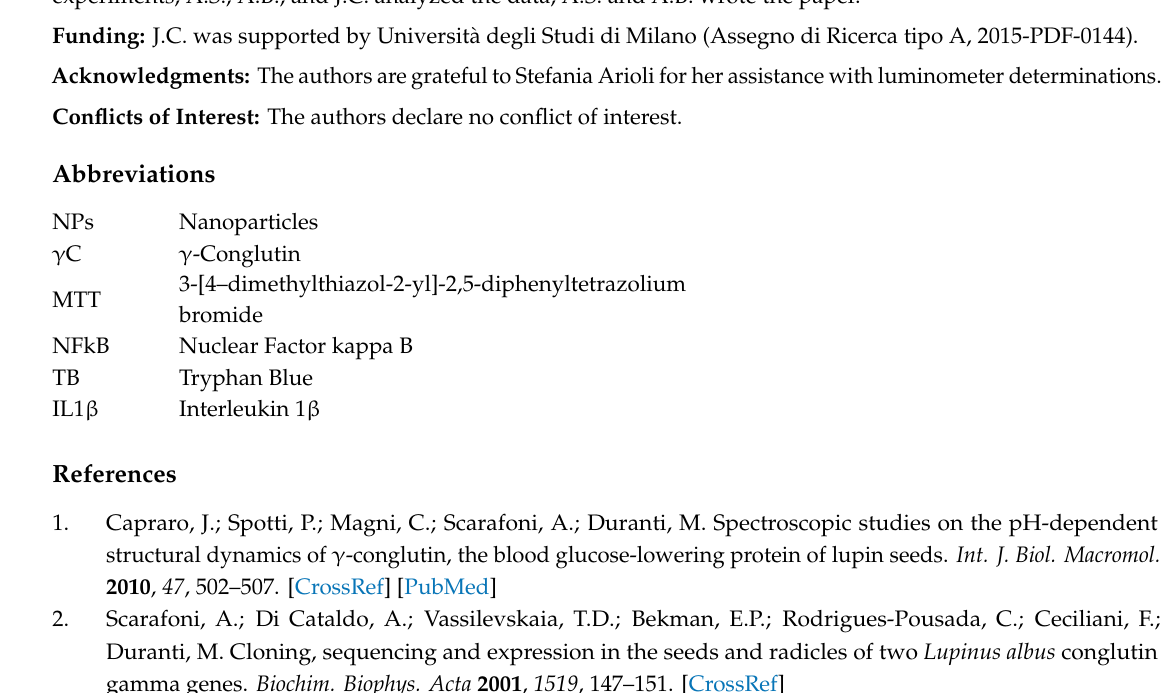
Figure S1: Prediction of peptides toxicity calculated by using the ToxinPred method [31], available on-line at http: // crdd.osdd.net / raghava / toxinpred / , using Uniprot KB:Q9FSH9 amino acid sequence of γ C as template, Figure S2: Panel A: native γ C incubated with trypsin for di ff erent times. Panel B: Incubation with trypsin e ff ects on γ C adsorbed to